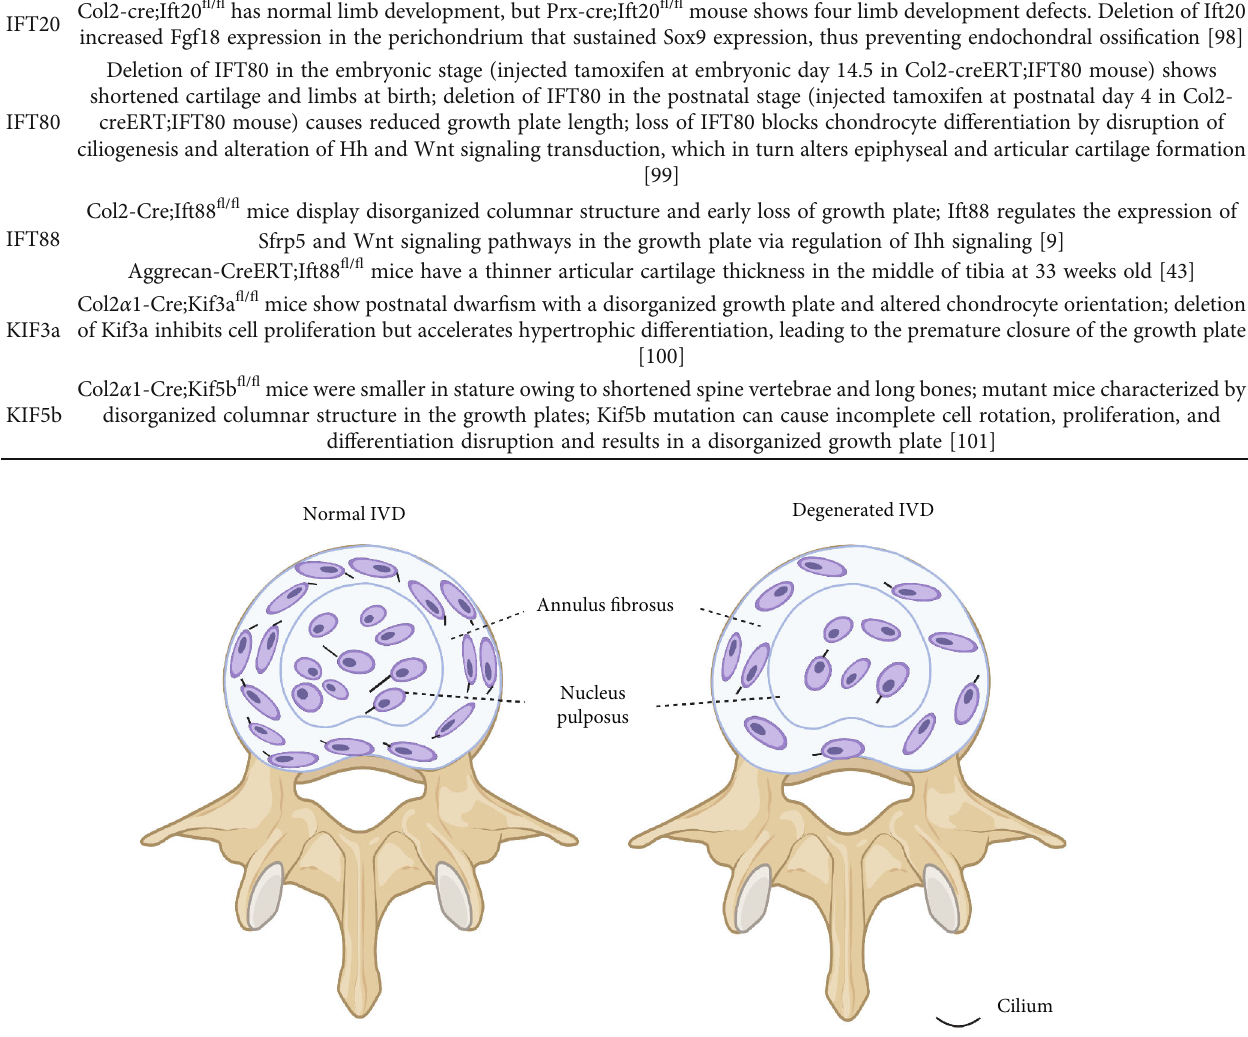
Table 2: The role of primary cilia in cartilage development illustrated by the conditional knock out mouse model. Gene Function Col2-cre;Ift20 fl / fl has normal limb development, but Prx-cre;Ift20 fl / fl mouse shows four limb development defects. Deletion of Ift20 IFT20 increased Fgf18 expression in the perichondrium that sustained Sox9 expression, thus preventing endochondral ossi fi cation [98] Deletion of IFT80 in the embryonic stage (injected tamoxifen at embryonic day 14.5 in Col2-creERT;IFT80 mouse) shows shortened cartilage and limbs at birth; deletion of IFT80 in the postnatal stage (injected tamoxifen at postnatal day 4 in Col2- IFT80